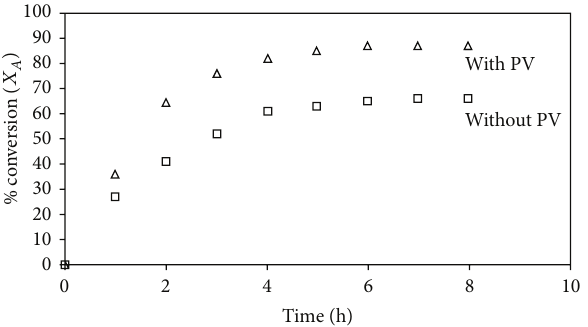
Figure 4: Effect of change in catalyst concentration on conversion of propionic acid ( 𝑇 = 80 ∘ C; 𝑅 = 1.4; 𝑆/𝑉 = 15.19 m 2 /m 3 ): 𝐶 𝐶 = 0.089 kmol/m 3 ( ◻ ), 𝐶 𝐶 = 0.179 kmol/m 3 ( × ), 𝐶 𝐶 = 0.268 kmol/m 3 ( l ), 𝐶 𝐶 = 0.358 kmol/m 3 ( ♢ ), 𝐶 𝐶 = 0.447 kmol/m 3 ( 󳵻 ).